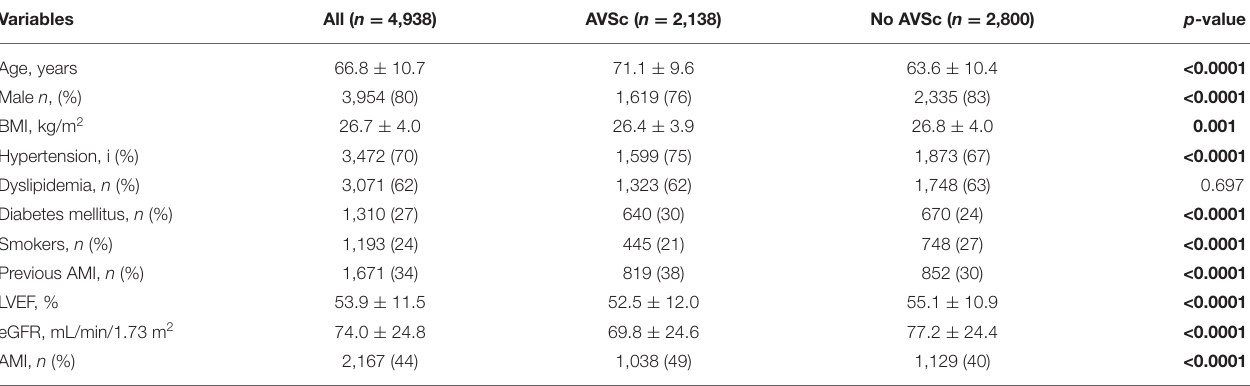
TABLE 1 | Demographic and clinical characteristics of the high-risk coronary artery disease patients divided by the presence of aortic valve sclerosis. Variables